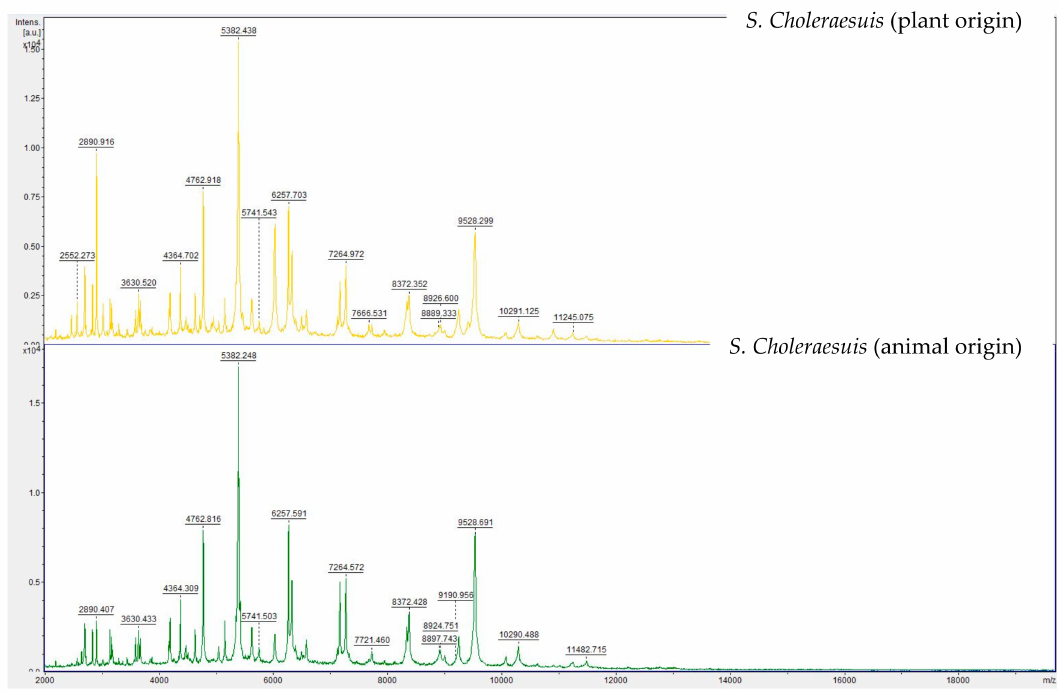
Figure 2. MALDI-TOF MS spectra of both Salmonella Choleraesuis strains displayed in